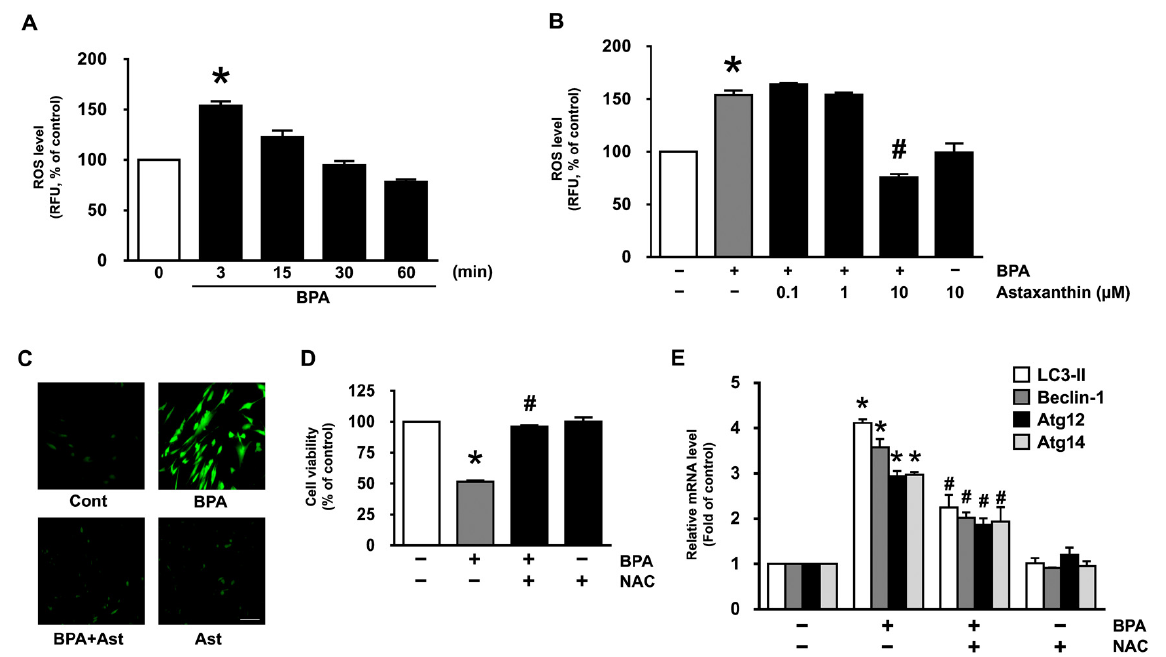
Figure 2. Antioxidative effect of astaxanthin on the production of ROS in NHDF treated with BPA. ( A ) Time responses of BPA (50 µ M) on the ROS production determined by staining NHDF with CM-H 2 DCFDA are shown. * p ≤ 0.001 versus control. n = 3. RFU, relative fluorescence units. ( B ) NHDF was exposed to the BPA in the presence of astaxanthin (0.1 and 10 µ M) for 3 min. * p ≤ 0.001 versus control. # p ≤ 0.001 versus BPA alone. n = 3. ( C ) The inhibitory effect of astaxanthin on ROS production induced by BPA (green) revealed by confocal microscopy is shown. Scale bars, 100 µ m (magnification × 100). n = 3. ( D , E ) Cells were treated with 1 µ M of N-acetylcysteine (NAC) as an antioxidant for 30 min prior to BPA exposure for 24 h. The effect of NAC on the levels of cell viability ( D ) and autophagic genes ( E ) is shown. * p ≤ 0.01 versus control. # p ≤ 0.05 versus BPA alone. n = 3.